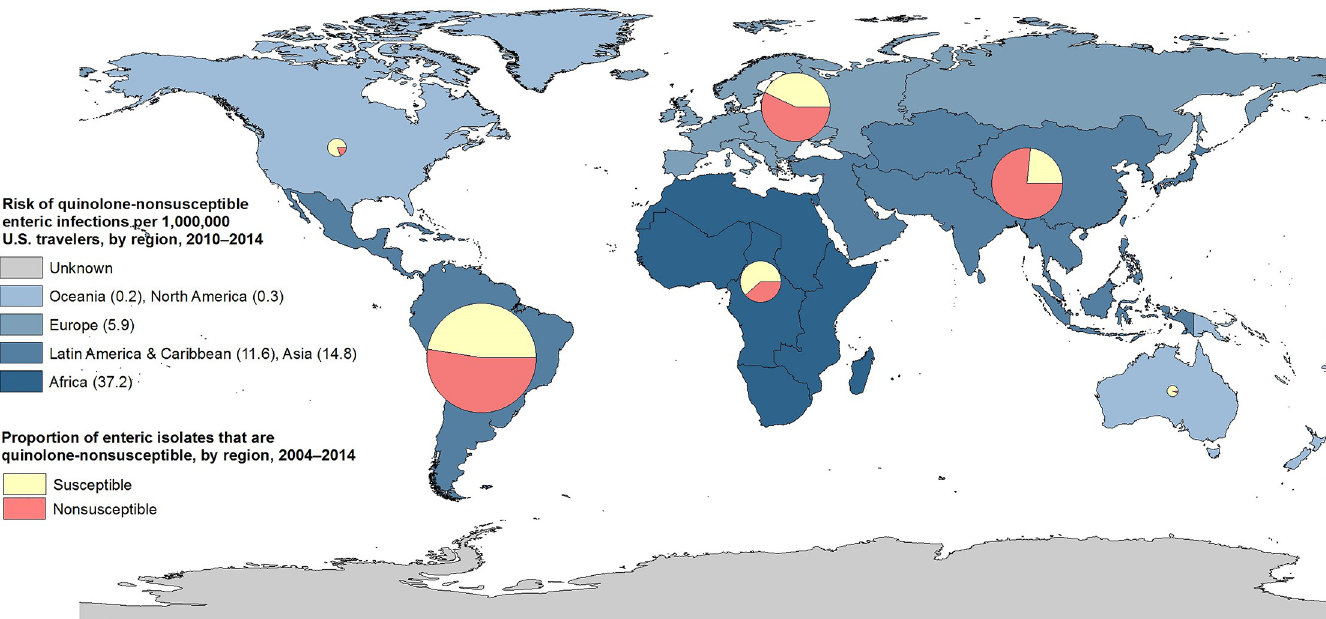
Fig 3. Proportion and risk of quinolone-nonsusceptible enteric infections in US travelers, by region, 2004–2014 � . � Displays, by region, both the risk of quinolone- nonsusceptible enteric infection (differentiated by map shading) and the proportion of enteric isolates that are quinolone-nonsusceptible (presented as pie chart). Size of pie is proportional to the number of isolates tested per